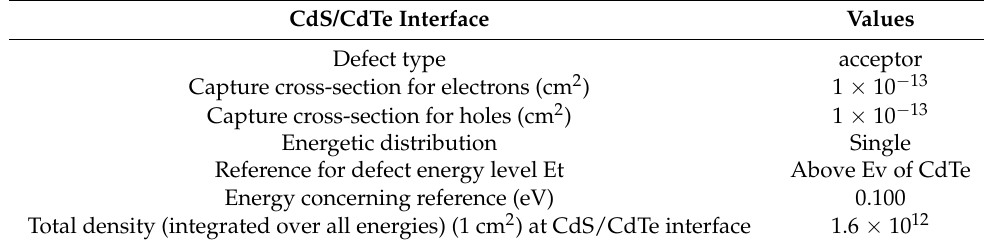
Table 2. CdTe solar cell parameters (CdS/CdTe interface).